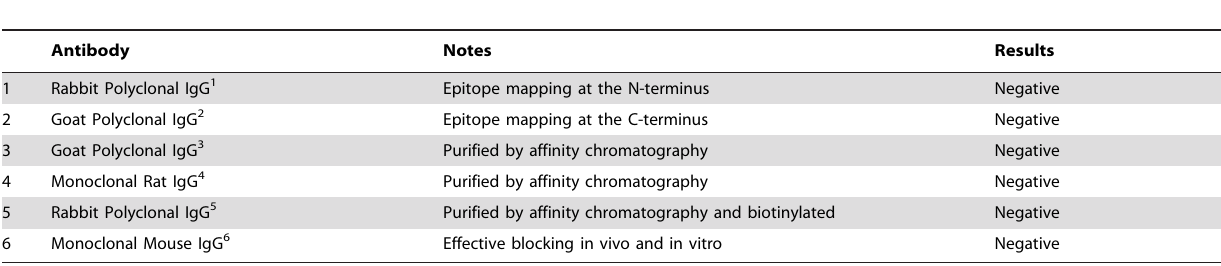
Table 1. Immunohistochemistry fails to detect IL-7 in murine thymus.